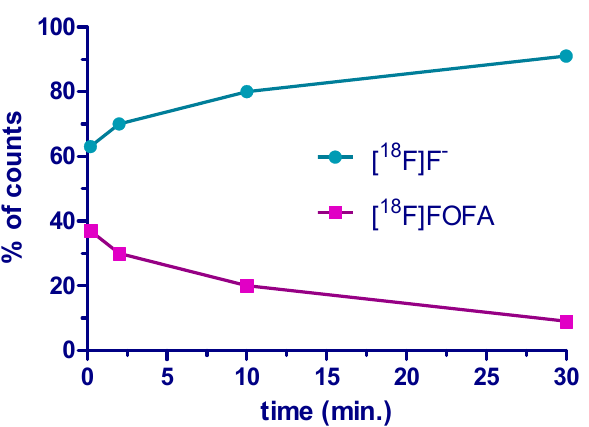
Figure 6. Illustration of [ 18 F]FOFA {[ 18 F]F- 1 }stability in terms of time activity curve by observing the decline of [ 18 F]FOFA {[ 18 F]F- 1 }and growth of the metabolites [ 18 F]F − from peak integration in HPLC chromatogram. The ex vivo half-life is approximately t 1/2 < 1 min.